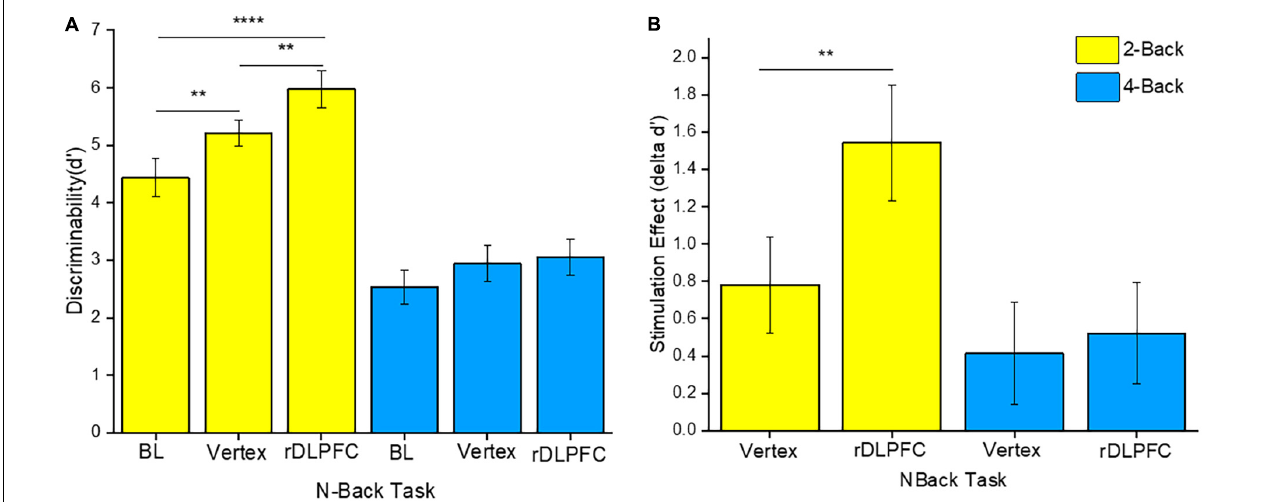
FIGURE 3 | (A) Discriminability index for both 2-back and 4-back tasks under different stimulation conditions, namely: Baseline (BL), iTBS over the vertex, and iTBS over the rDLPFC. (B) The stimulation effect ( δ d’ scores). The stimulation effect was obtained by subtracting the BL scores from the post-stimulation scores. The yellow and the blue colors refer to the 2-back and 4-back tasks, respectively. The asterisks indicate the level of significance, with ** indicating p ≤ 0.01, and **** indicating p ≤ 0.0001. The errors bars indicate the standard mean error (SME).